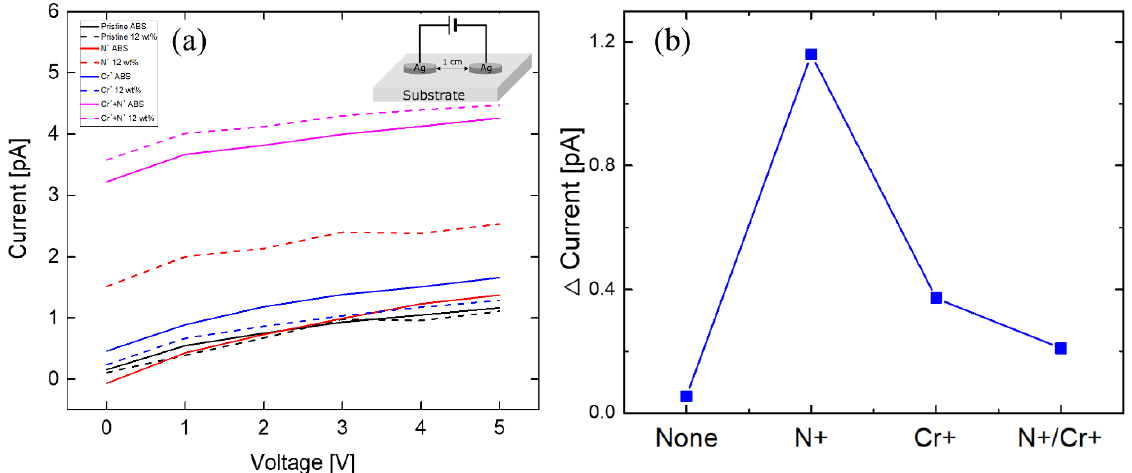
Figure 9. ( a ) Investigation of surface electrical properties through I–V measurement after nitrogen ion beam and chromium ion beam irradiation. ( b ) The difference in current when a voltage of 5 V was applied is shown. ( a ) Inset image shows I-V measuring element.